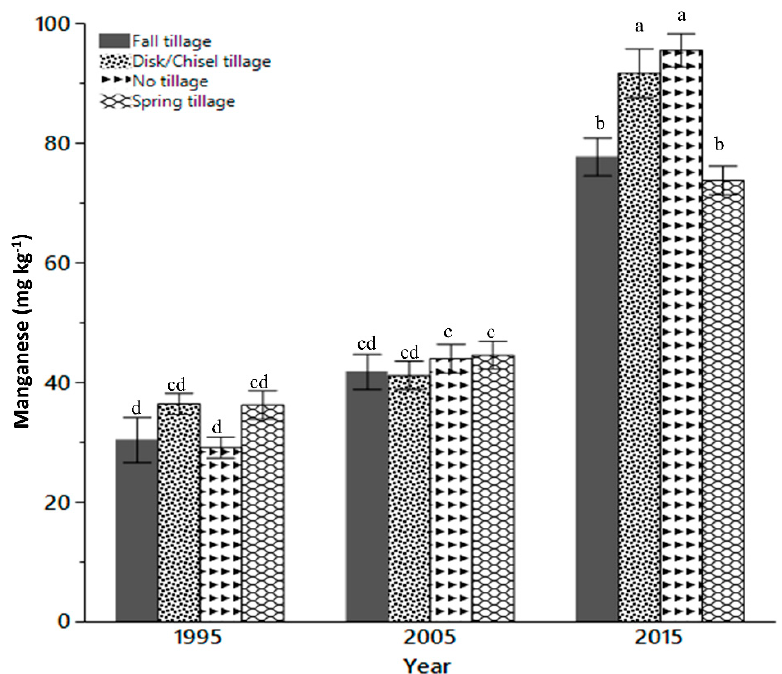
Figure 4. Effect of tillage methods on the concentration of manganese in wheat straw over the 20-year time period. Letters above the bars show a comparison of 12 combinations of treatment and year. Bars sharing the same letter are not significantly different at 5% probability level. Error bars represent the standard error of the least square mean.